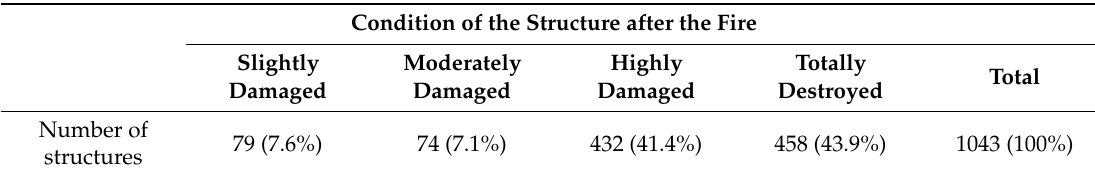
Table 3. Number of structures inventoried per degree of damage. Condition of the Structure after the